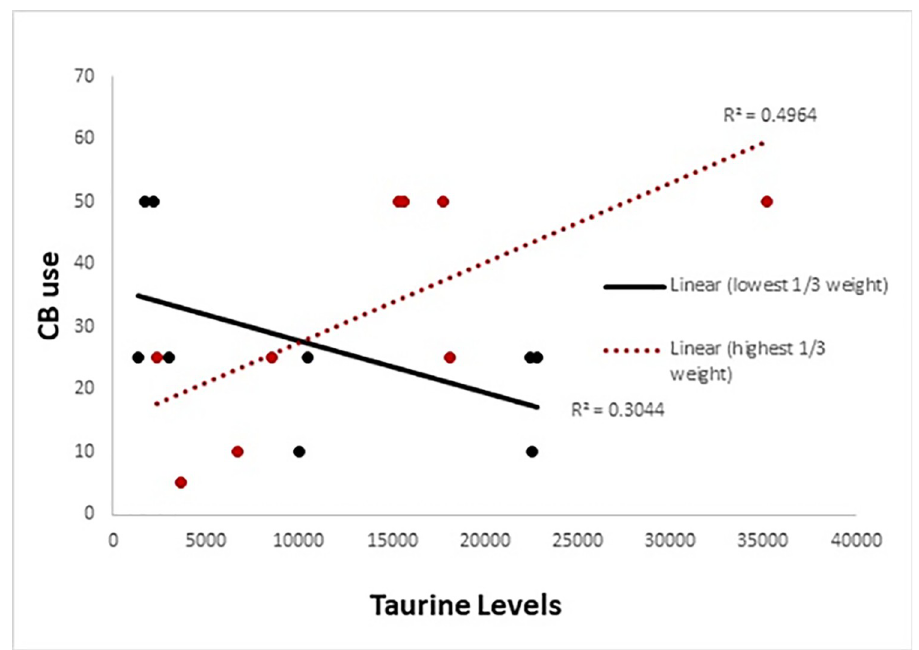
Fig 2. Expt 2 results. For demonstration purposes only in order to visualize the interaction for Expt 2 (metabolomics analysis), participants were ranked into thirds based on weight. The red line depicts the relationship between CB use and taurine for the participants with the highest weight and the black line depicts those with the lowest weight.